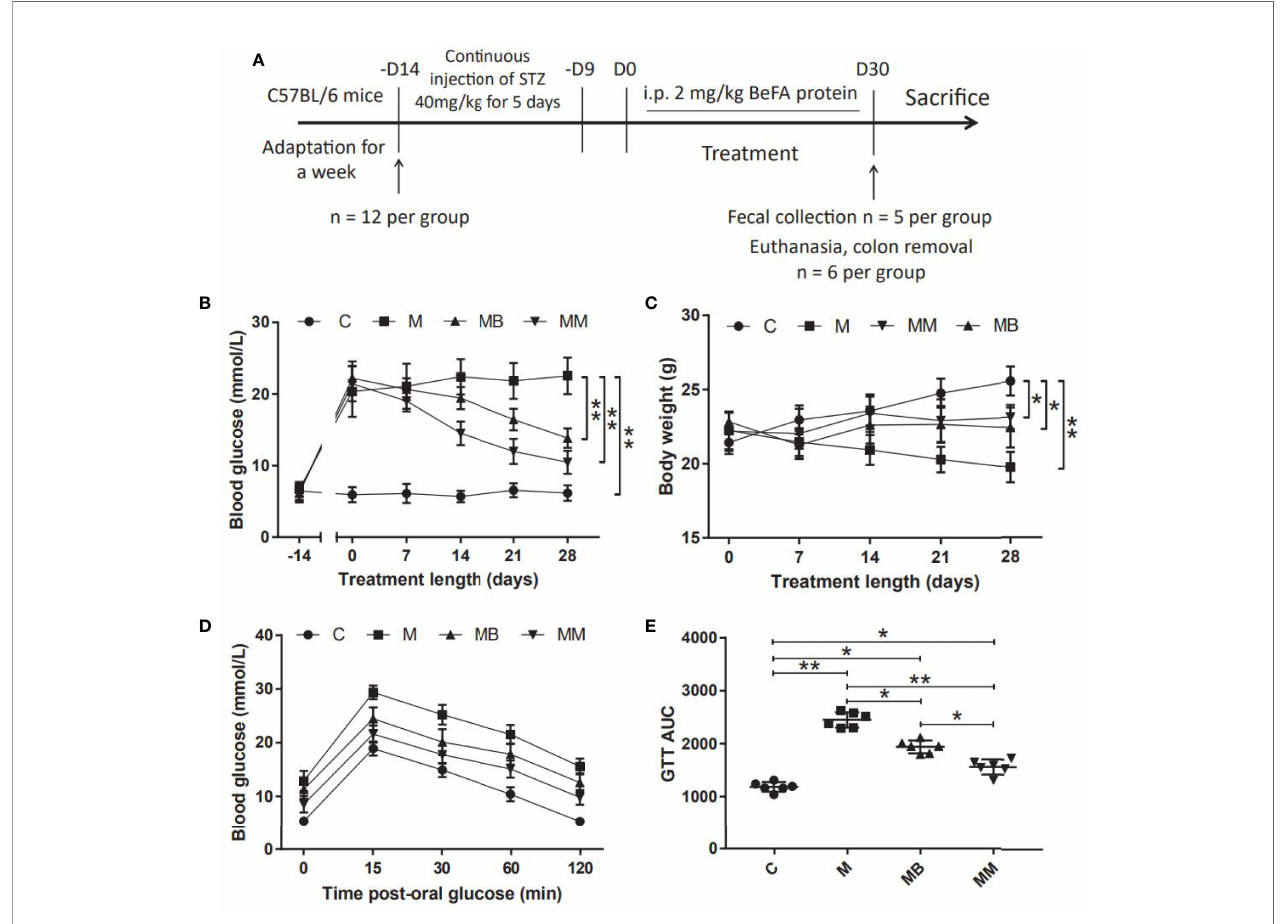
FIGURE 1 | BefA protein improves blood glucose and body weight in MLD-STZ induction of T1DM mice. (A) Treatment schedule of BefA protein for MLD-STZ induction of T1DM model. (B, C) Changes in blood sugar and body weight over time in C, M, MB and MM group (n = 12). (D, E) Levels of blood glucose and area under the curve (AUC) during a GTT in C, M, MB and MM group (n = 6). Data are presented as means ± SD. Two-way repeated-measures ANOVA both with Tukey ’ s test for multiple comparisons ( B – D , respectively) and One way repeated-measures ANOVA with Tukey ’ s test for multiple comparisons (E) ; * p < 0.05, ** p <